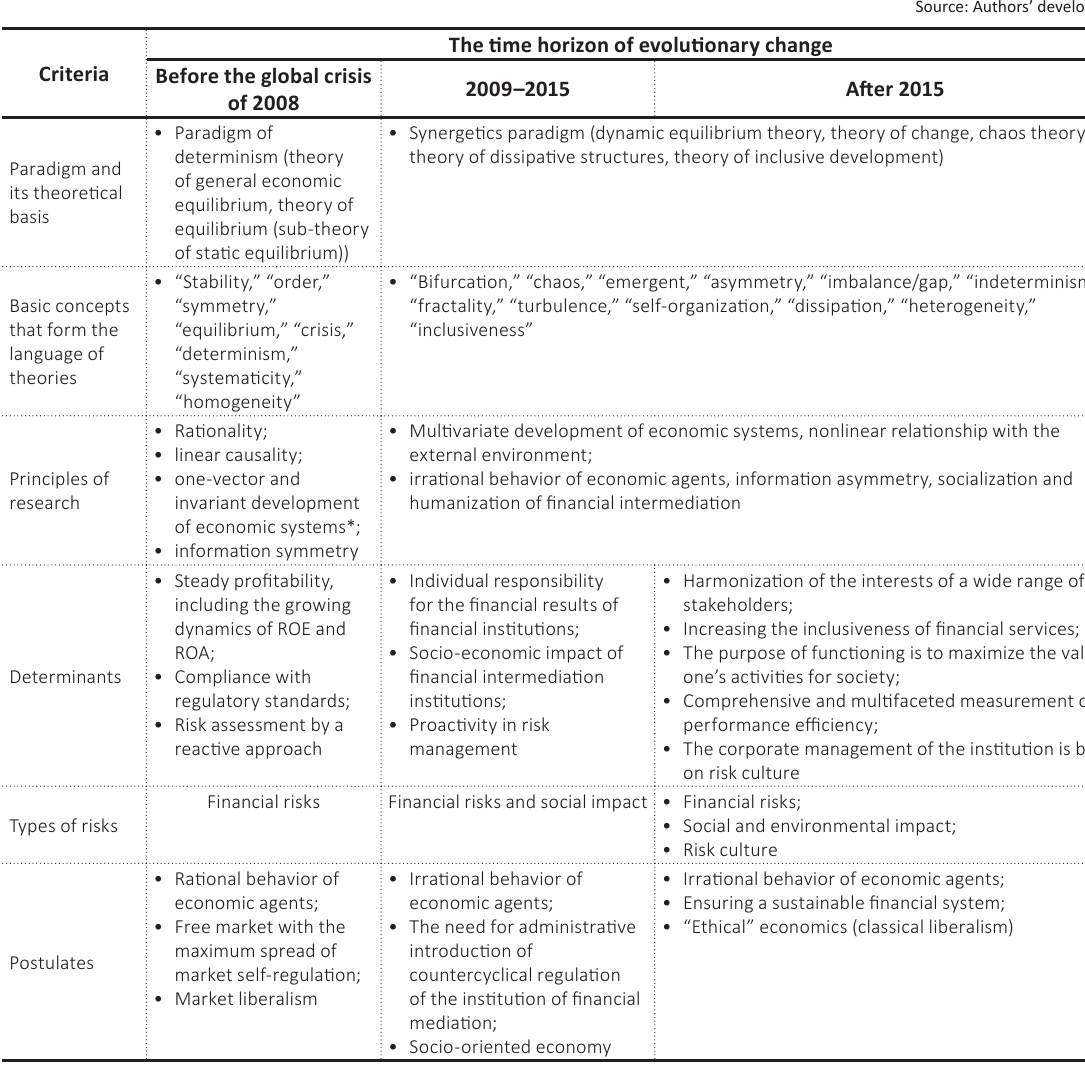
Table 1. Evolutionary transformation of financial stability in the financial sector